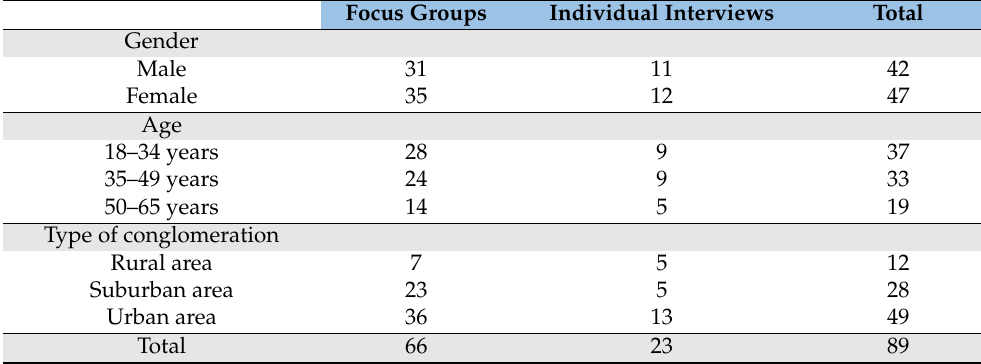
Table 1. Sociodemographic description of smokers interviewed during the qualitative post-tests (n), November 2020–February 2021. Focus